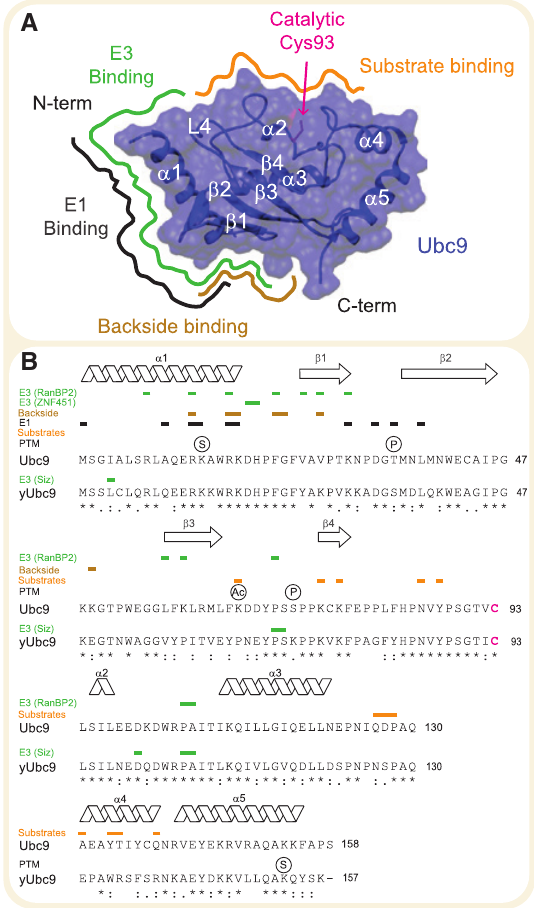
Figure 3: The multiplicity of E2 interactions. (A) An overview of the indicated binding interfaces on a surface structure of Ubc9 [blue, based on 3UIN, (193)] is shown. The N-terminus (N-term) of Ubc9 binds the E1 (black line) and selected E3s (green line). The E2 catalytic cleft around Cys93 directly rec- ognizes a SCM in substrates, but in addition various E2-substrate binding interfaces have been mapped near to the catalytic cleft (orange line, see also Figure 4). The backside of Ubc9, opposite to its catalytic center, binds SUMO (brown line) and this surface par- tially overlaps with the E1 and selected E3 interaction sites. C-term indicates the C-terminal end of the protein, secondary structure elements ( α : alpha helix, β : beta sheet) are labeled and numbered. (B) A sequence alignment of human and yeast Ubc9 is shown with structural features indicated. Amino acids involved in the individual interactions are shown in the same color as in (A). Residues that are targets of modifications are indicated as Ac for acetylation, S for sumoylation and P for